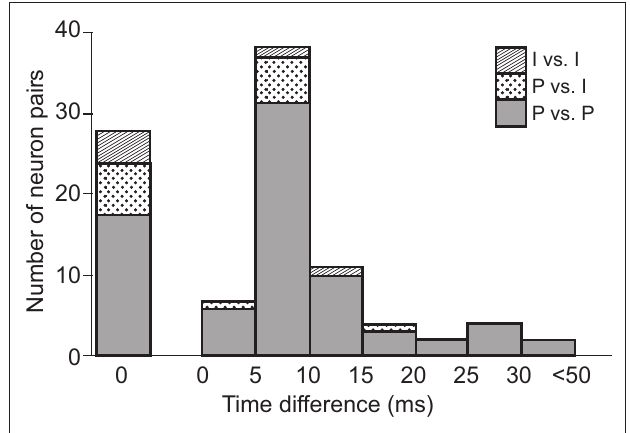
Figure 13 | Frequency histogram of the time differences of the CCg peaks in terms of the types of the neuron pairs. P vs. P, pyramidal neuron vs. pyramidal neuron; P vs. I, pyramidal neuron vs. interneuron; I vs. I, interneuron vs. interneuron.